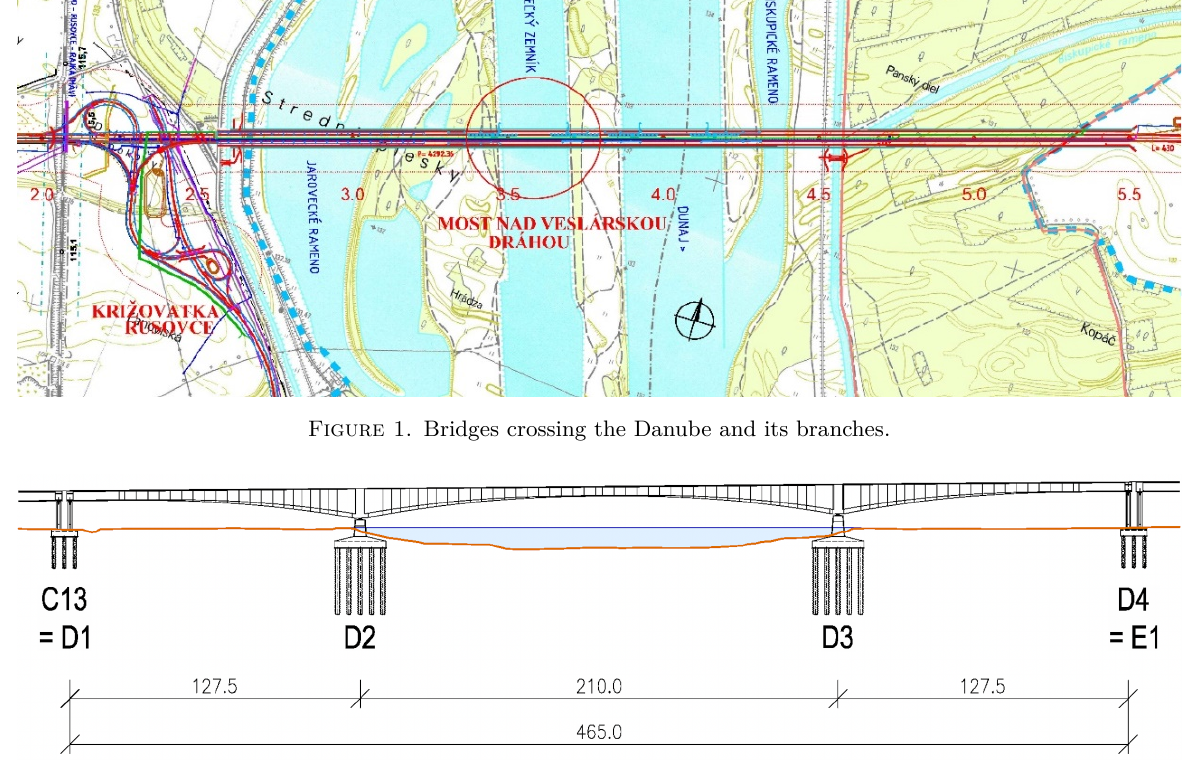
Figure 2. B Longitudinal